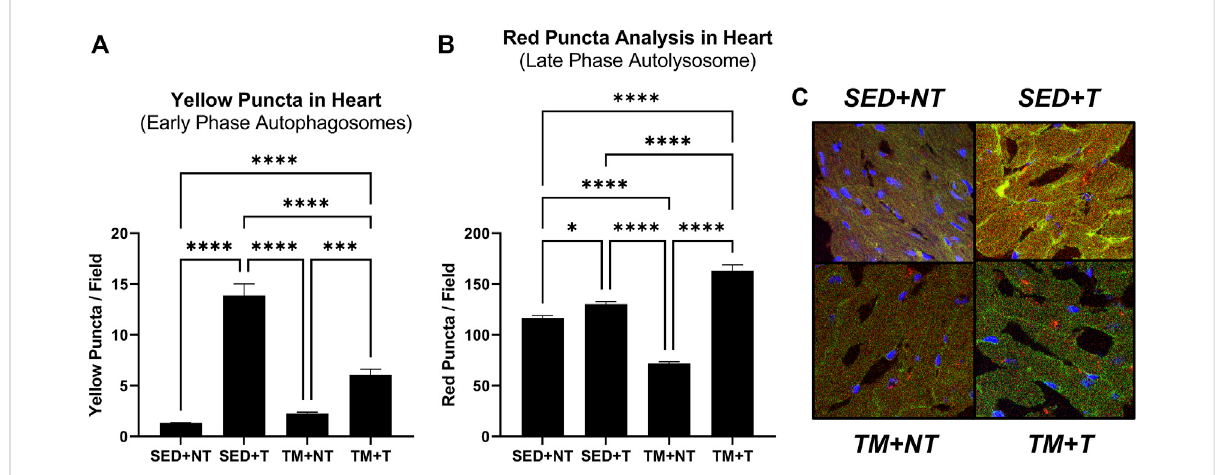
FIGURE 4 Cardiac Autophagy. Tumor bearing signi fi cantly increases early phase (A) and late phase autophagy (B) . Representative images (C) . Preconditioning treadmill endurance exercise modulates early phase autophagy (A) . SED, sedentary; TM, preconditioning treadmill endurance exercise training; T, tumor bearing; NT, non-tumor. Data are presented as mean ± SD. * p < 0.05, ** p < 0.01, **** p <